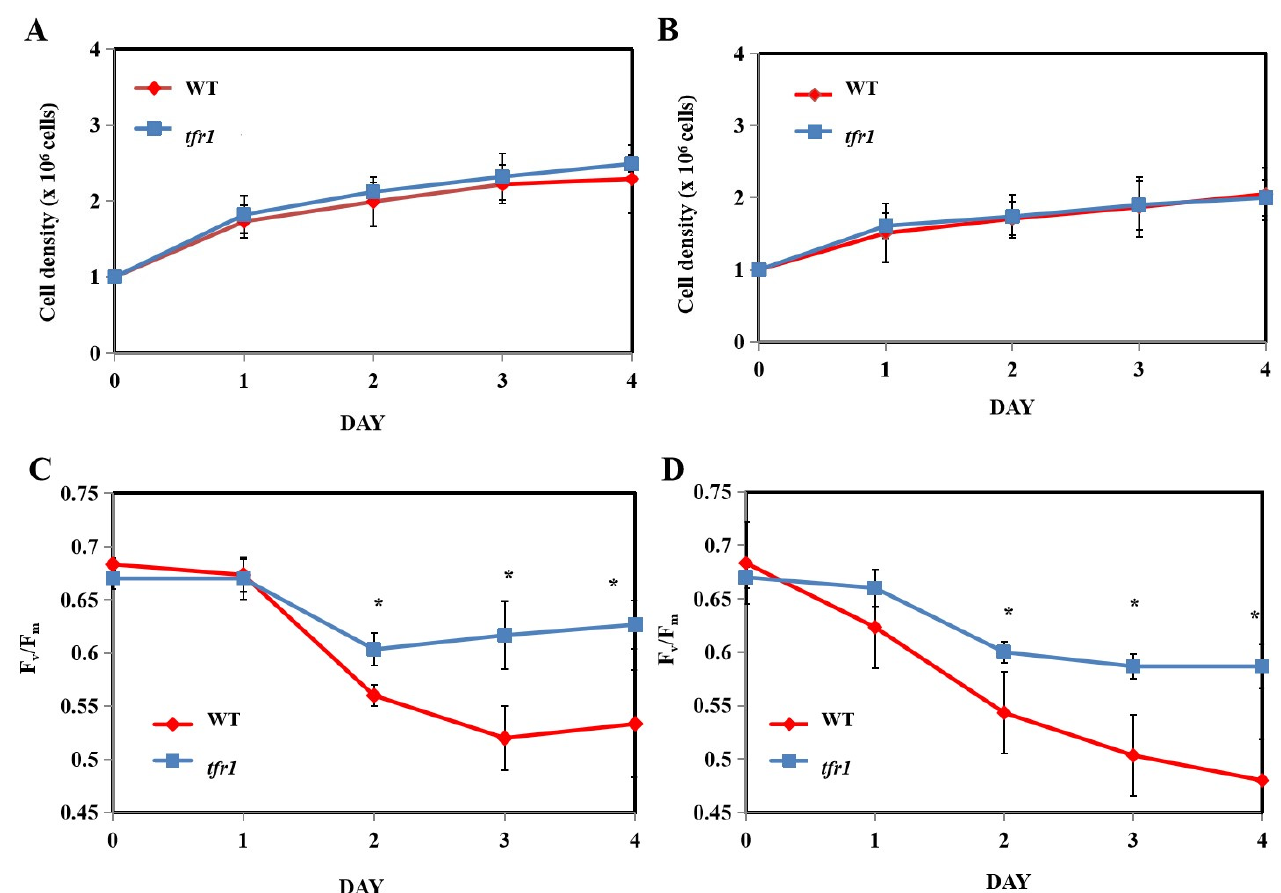
Figure 8. Growth and maximum quantum yield (F v /F m ) parameter of wild type (WT) and tfr1 mutant in nitrogen-depleted medium ( A , C ) and nitrogen-depleted medium with terbinafine ( B , D ). All data are means ± SD of three biological replicates. Significant differences between the wild type (WT) and the mutants within the same condition are indicated by asterisks (*) ( p < 0.05).